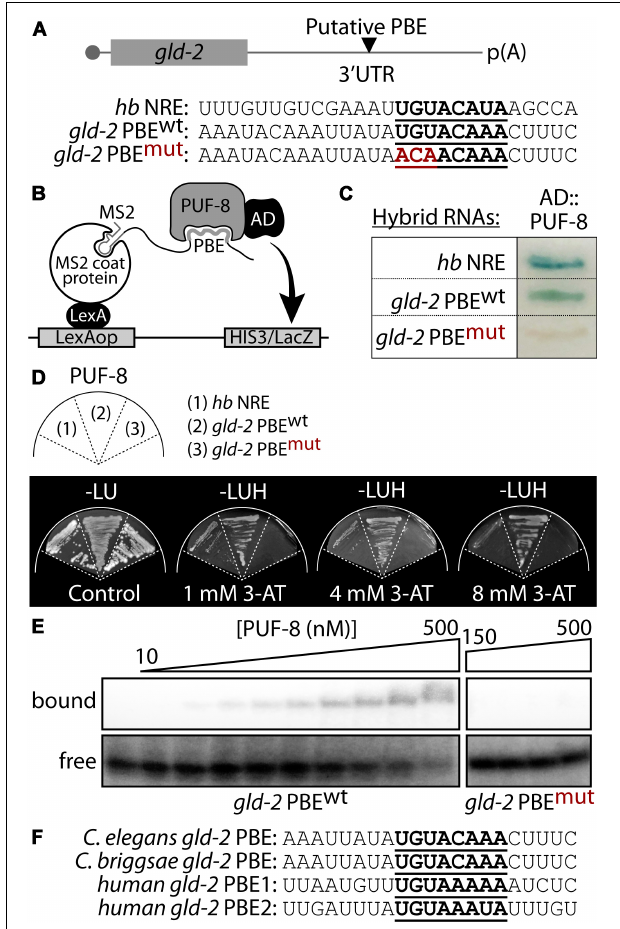
FIGURE 2 | PUF-8 binds specifically to a PBE in gld-2 3 (cid:48) UTR. (A) A putative PBE in gld-2 3 (cid:48) UTR. Nucleotide sequences of a predicted PBE (see bold letters). Wild-type sequence is followed by its mutant, in which UGU is replaced by ACA. hunchback (hb) NRE (Nanos Response Element) served as a positive control for PUF-8 binding. (B) Schematic of yeast three-hybrid assay. (C) Three-hybrid interactions assayed by β -galactosidase activity. (D) HIS3 reporter activation. Growth was monitored on media lacking histidine and containing different concentration of HIS3 competitor 3-AT. (E) Gel retardation assay. Purified PUF-8 binds gld-2 PBE wt , but does not bind gld-2 PBE mut with an altered consensus as detailed in panel (A) . (F) Sequence alignment of gld-2 PBEs from C. elegans , Caenorhabditis briggsae , and human